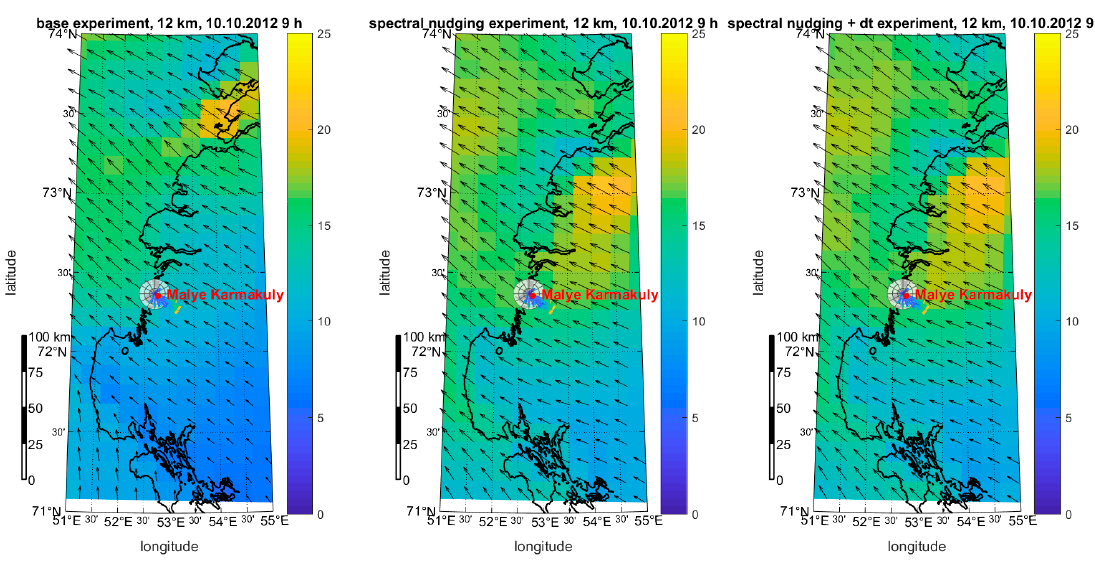
Figure 4. Wind speed (m/s) and direction at the Malye Karmaluly station region on 10 October 2012 at 09:00 GMT for the three experiments with ≈ 13 km grid (standard, *_sn, *_sn_dt).